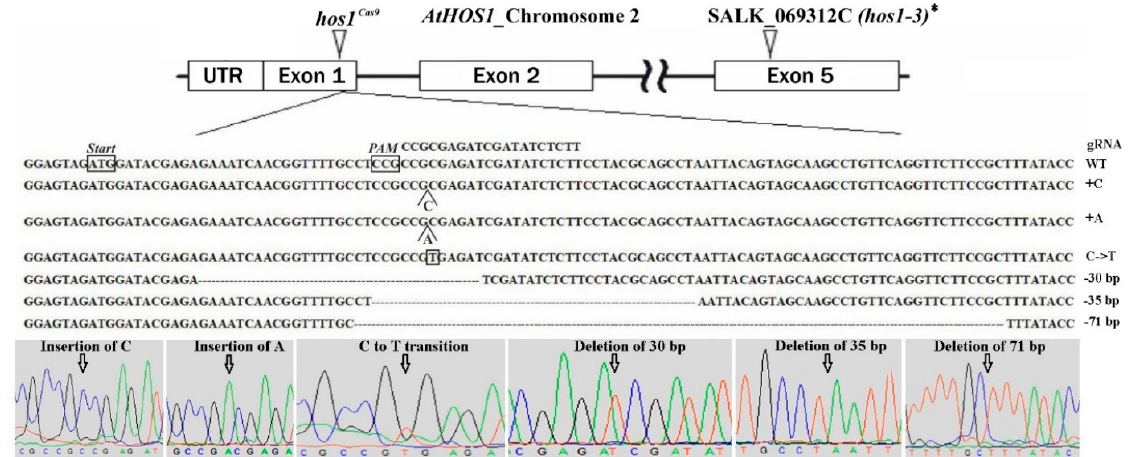
Figure 2. Schematic illustration of the gRNA1 target site in HOS1 gene. The detail underneath shows partial sequences for the native and mutated HOS1 alleles. The sequence chromatograms are taken from Trev 1.8b1 (Staden Package). The positions of each of the identified mutations are marked with arrows. * The precise position of T ‐ DNA integration site within the HOS1 gene and predicted sequence of the truncated protein in the hos1 ‐ 3 mutant line are shown in Figure S4 of Supplementary Materials.